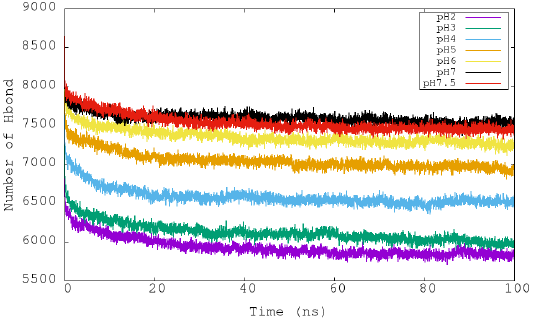
Figure 5. Representation of the temporal evolution of the number of total intramolecular hydrogen bonds of urease in molecular dynamics simulations at pH 2, 3, 4, 5, 6, 7 and